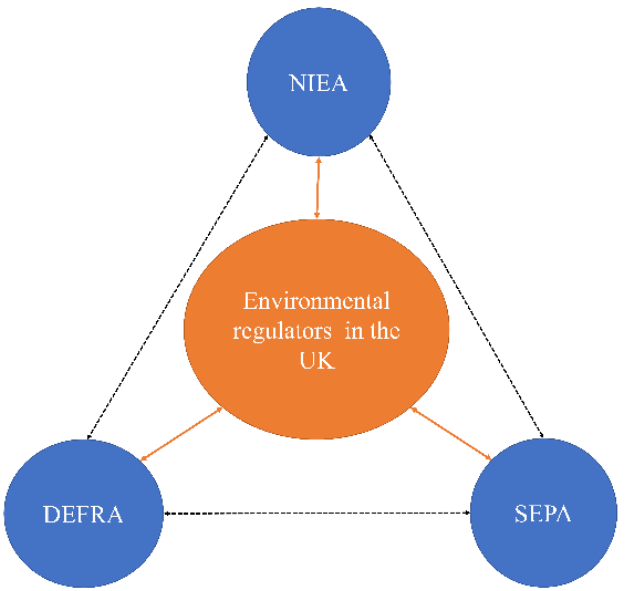
Figure 1. Agricultural Environmental Pollution Management System in the UK. DEFRA: department for environment food and rural affairs; SEPA: Scottish environmental protection agency; NIEA: Northern Ireland environment agency.